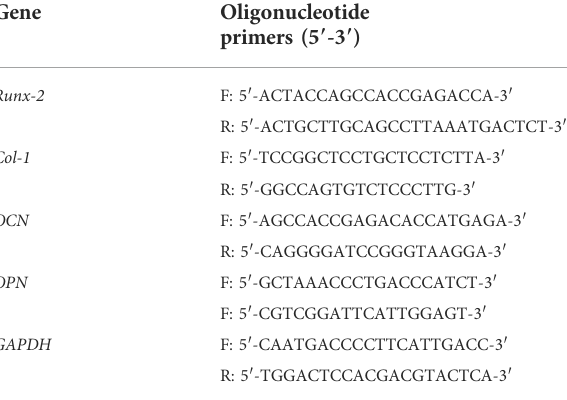
TABLE 1 Primer sequences of